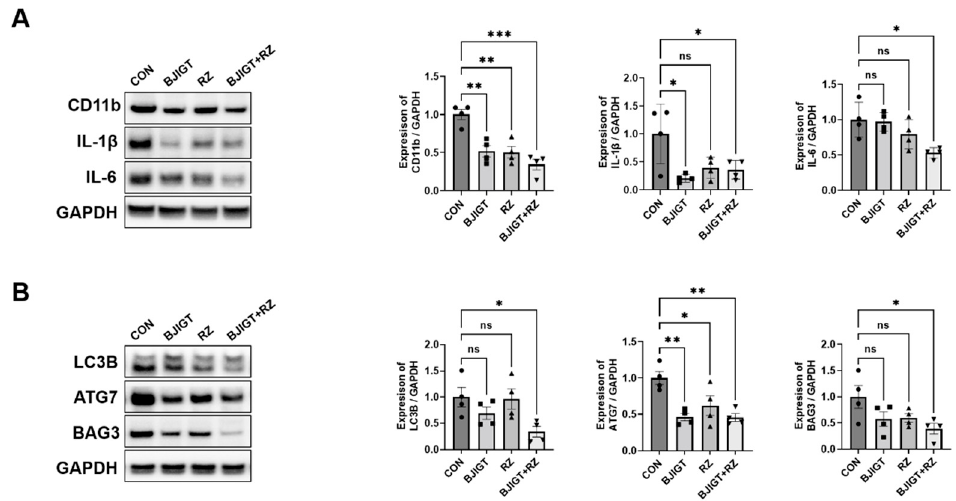
Figure 1. Combined BJIGT/RZ treatment regulates inflammation and autophagy dysfunction in the GC of hSOD1 G93A amyotrophic lateral sclerosis (ALS) mice. ( A ) Representative Western blots depicting alterations in inflammation-related proteins including cluster of differentiation 11b (CD11b), interleukin 1 β (IL-1 β ), and IL-6 in the GC of control, BJIGT, RZ, and combined BJIGT/RZ treatment groups of hSOD1 G93A mice. Glyceraldehyde-3-phosphate dehydrogenase (GAPDH) was used as a loading control to normalize protein levels. Quantification of bands showing the levels of CD11b, IL-1 β , and IL-6 in the drug treatment group compared with that in the control group ( n = 4/group). ( B ) Representative Western blots showing the alterations in autophagy-related proteins including microtubule-associated protein 1A/1B light chain 3B (LC3B), autophagy related 7 (ATG7), and BCL-2–associated athanogene 3 (BAG3) in the GC of each group of hSOD1 G93A mice. GAPDH was used as a loading control to normalize the protein levels. Quantification of bands pertaining to LC3B, ATG7, and BAG3 in the drug treatment groups compared with those in the control group ( n = 4/group). Data are normalized to the control groups and presented as mean ± SEM. ns; not signifi- cant, * p < 0.05, ** p < 0.01, and *** p < 0.001, compared with the control group. Distilled water (DW)-administered transgenic (Tg) mice (CON), BJIGT-treated Tg mice (BJIGT), RZ-treated of Tg mice (RZ), and combined BJIGT/RZ-treated Tg mice (BJIGT+RZ). The different number of circles, squares and triangles are indicated the number of sample sot.